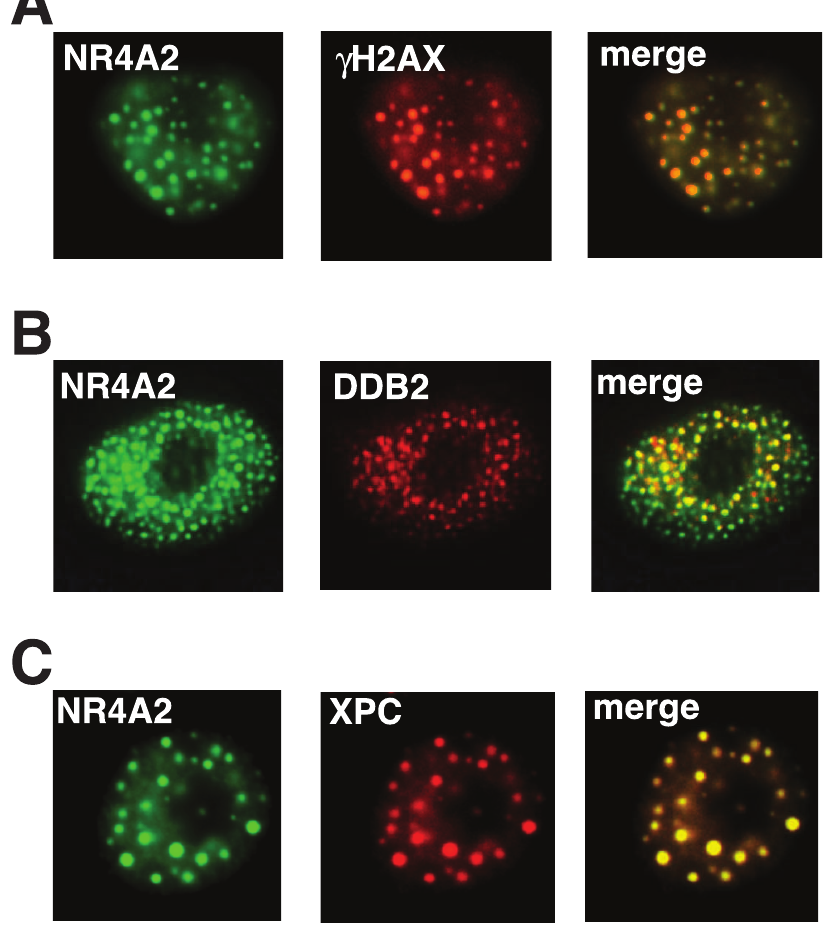
Figure 3. NR4A2 co-localises with DNA repair proteins following UVR treatment. MM96L cells transfected with pEYFP-NR4A2 were irradiated with 25 mJ/cm2 UV, fixed at 4 hours post-UV treatment and probed with primary antibodies against endogenous ( A ) c H2A.X or ( B ) DDB2 or ( C ) XPC proteins as indicated. Left panels, pEYFP-Nurr1 fluorescence (green); middle panel, immunofluorescence (red); centre right, merged images; right, DAPI staining. These data are representative images from 4 independent